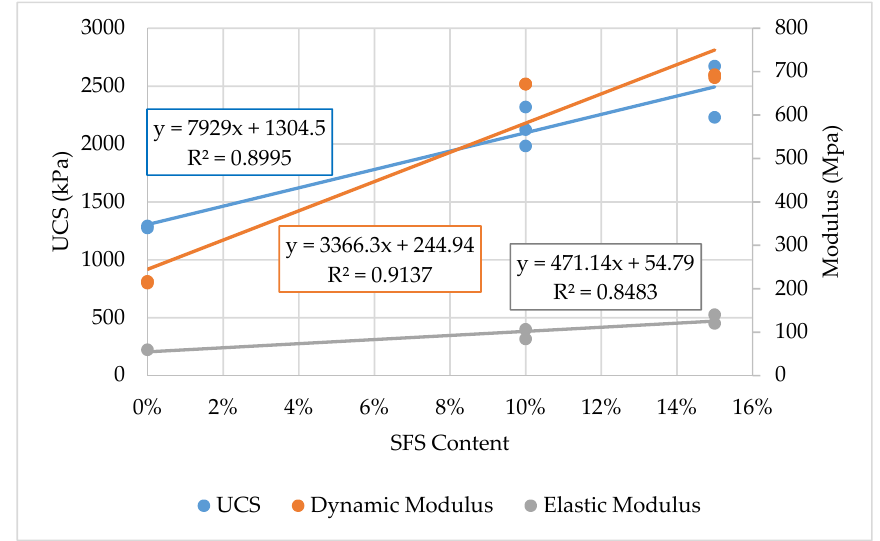
Figure 9. Relationships between UCS and modulus with the SFS content (without CaCl 2 ).